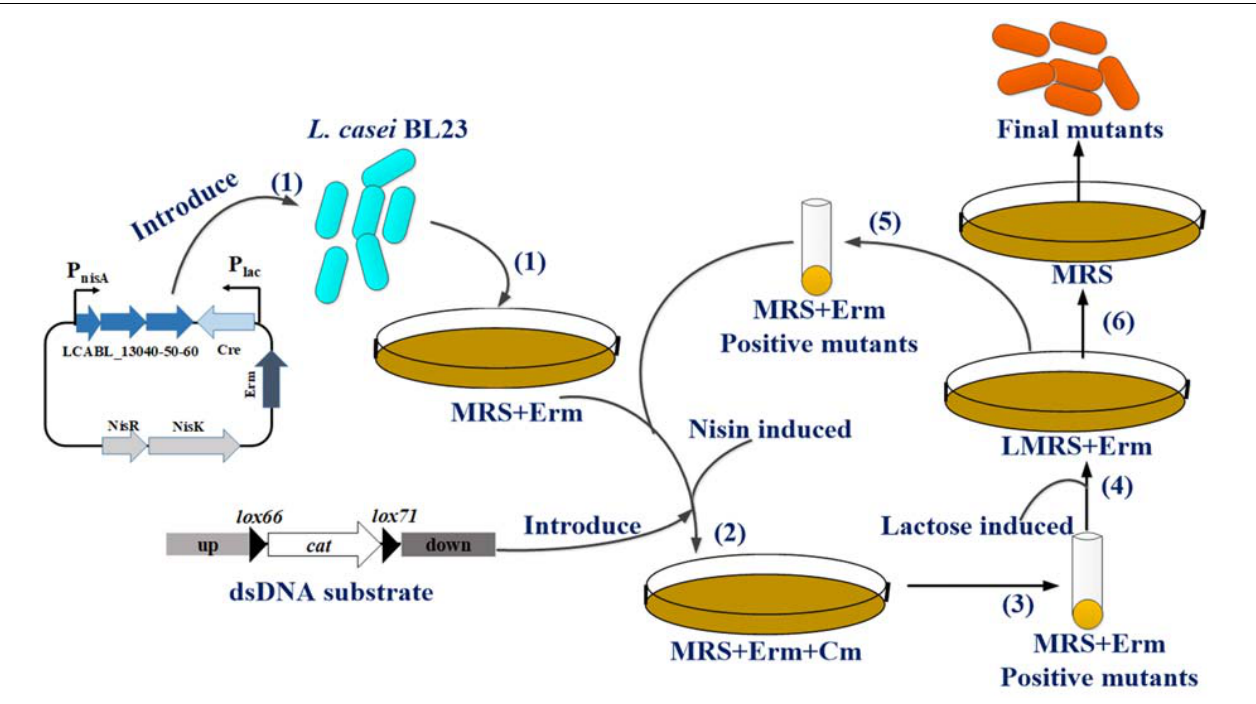
FIGURE 3 | Overall scheme for iterative gene deletions using the single-plasmid system in L. casei BL23. (1) Plasmid pMSP456-Cre is first loaded into L. casei BL23 cells and selected the recombinants by MRS plates supplemented with 5 µ g/mL erythromycin (Erm). (2) L. casei BL23 or derivates harboring plasmid pMSP456-Cre are made competent for electroporation of dsDNA substrate (up- lox66-cat-lox71 -down) after induced with nisin to expression prophages LCABL_13040-50-60 and selected by MRS plates supplemented with 5 µ g/mL Erm and chloramphenicol (Cm). (3) Recombinants are grown on Erm/Cm plates and positive mutants are verified by PCR with appropriate primers. (4) The positive mutants are grown on LMRS plates with 5 µ g/mL Erm to induce the Cre recombinase expression for cat (chloramphenicol resistant gene) excision. (5) Positive mutants were also picked and verified by PCR and went to step (2) for sequential deletions or step (6) to obtain the final mutants could grow on MRS without selection to cure the plasmid pMSP456-Cre to terminate the cycle.